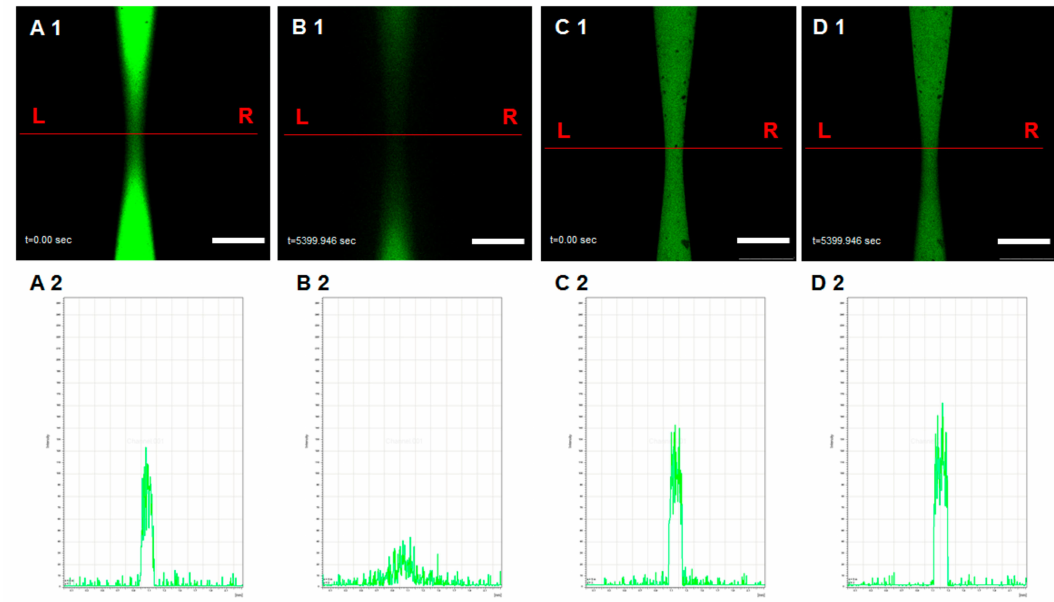
Figure 3. Microchannel permeability assay: ( A1 , B1 ) The permeability of microchannel for a micromolecule (A1,B1; FITC-Dextran, 40 kDa); ( C1 , D1 ) The permeability of microchannel for biomacromolecule (C1,D1; FITC-Dextran, 500 kDa). ( A2 – D2 ) indicate the fluorescence intensity. Scale bar: 500 µ